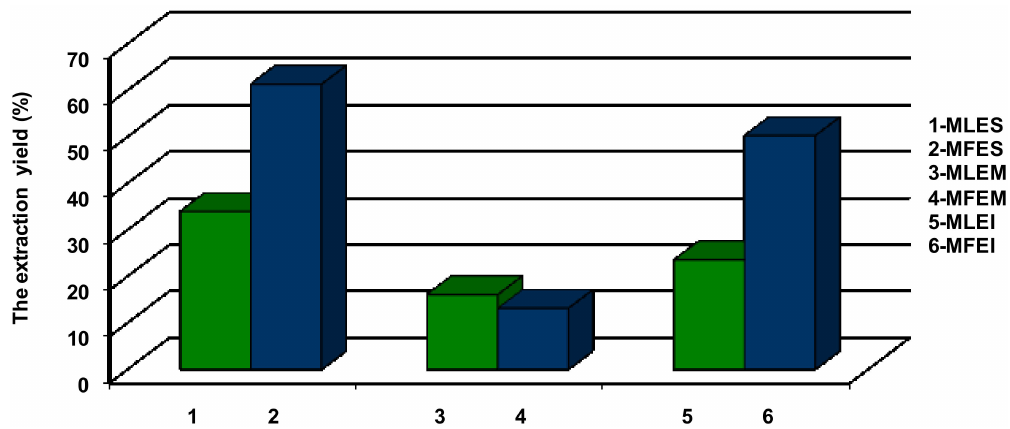
Figure 1. The extraction yields (%): MLES— Myrtilli folium extract obtained by